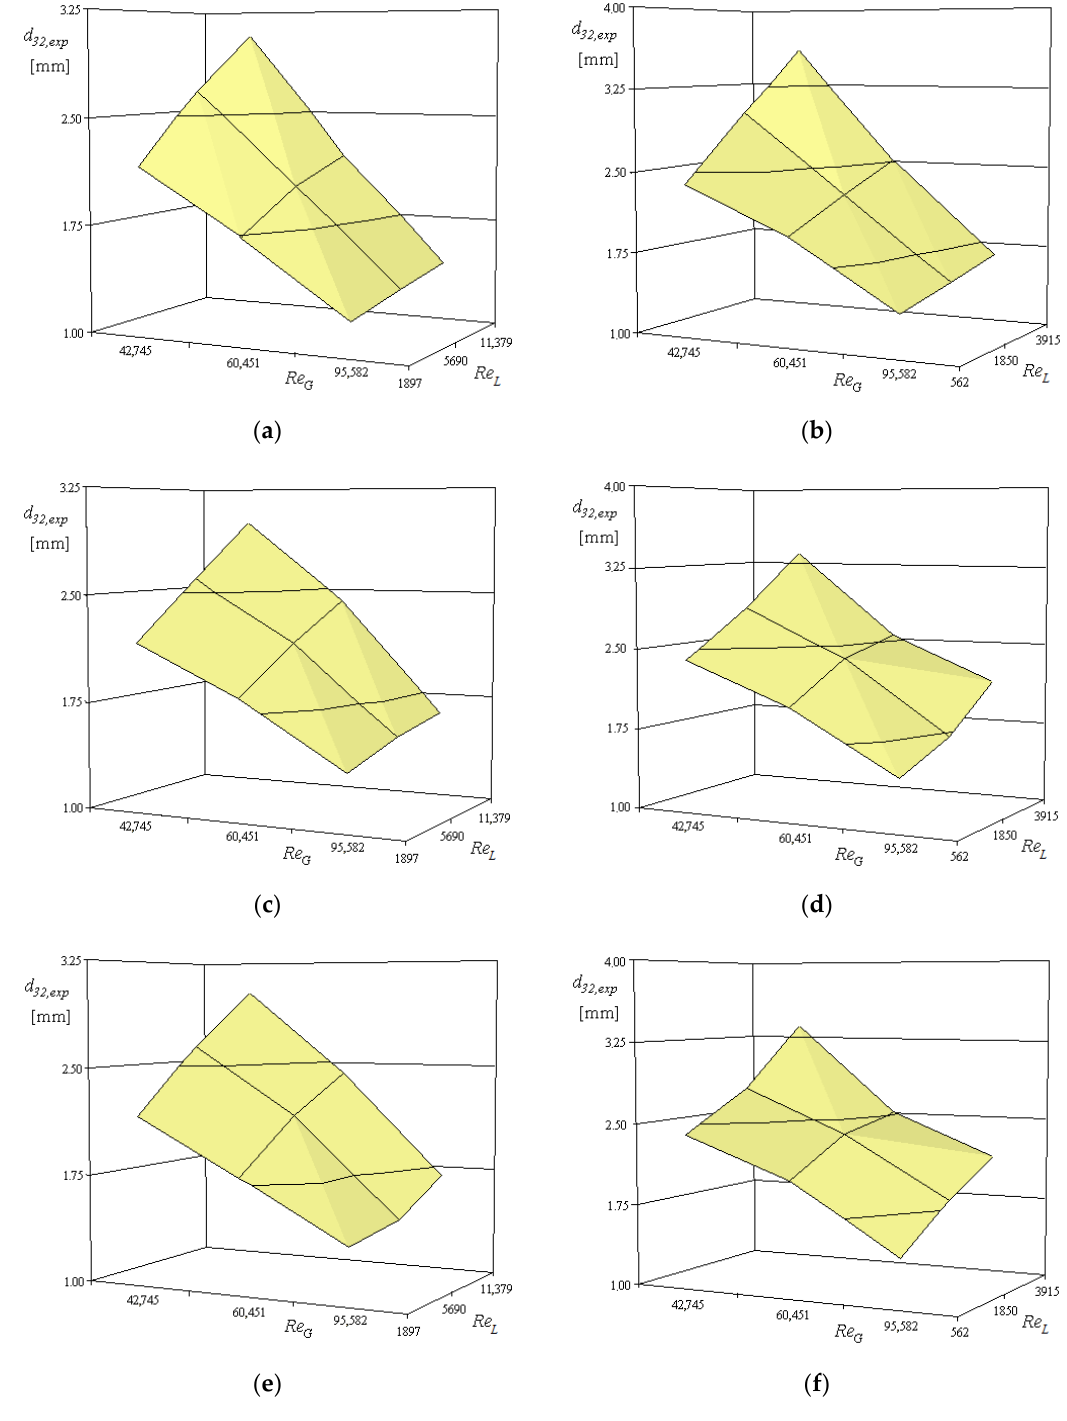
Figure 6. The Sauter diameter for air – water system ( a,c,e ) and air – polyacrylamide (PAA) solution ( b,d,f ). ( a,b ) K 0 ; ( c,d ) K 1 ; and ( e,f ) K 2 .